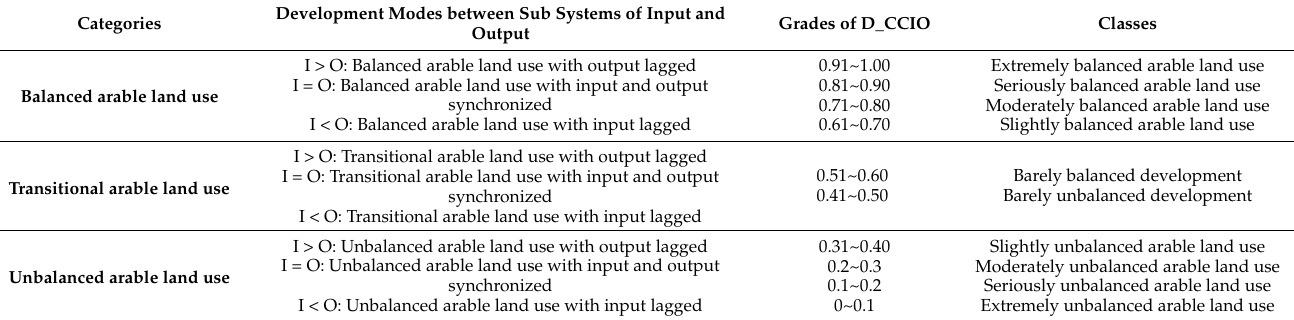
Table 2. Classifications of degree of coupling coordination between input and output on arable